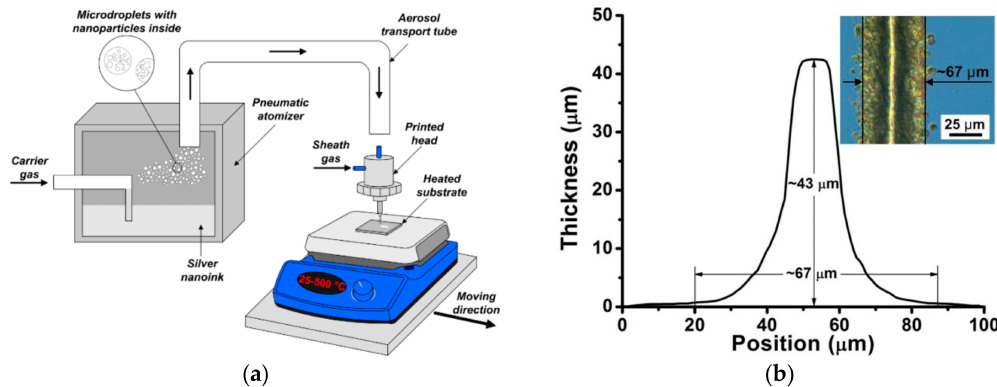
Figure 1. Schematic of an experimental setup for focused deposition of aerosol particles on a heated silicon substrate ( a ); An example of a cross-sectional profile of a silver line, measured with an optical profilometer, where the measured thickness t, width W and aspect ratio AR of the line are ~ 67 µ m, ~ 43 µ m and 0.64, respectively. The characteristic lengths of the formed lines in the experiments ranged from 10 to 30 mm. The inset shows the optical image of this line ( b